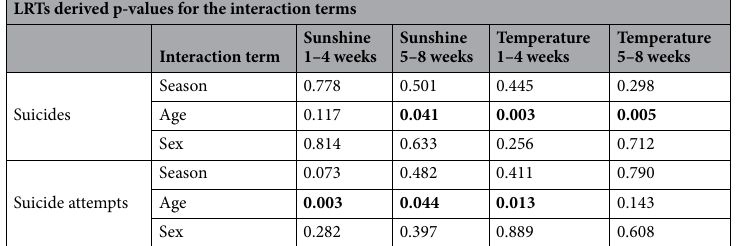
Table 3. P-values for likelihood ratio tests (LRTs) testing the models including interaction terms (e.g. season of treatment initiation × average daily sunshine 1–4 weeks) against the models without the interaction terms. All models were adjusted for previous suicide-attempt, county, sex, age, year and season when the antidepressant treatment was initiated. P-values < 0.05 are given in bold.